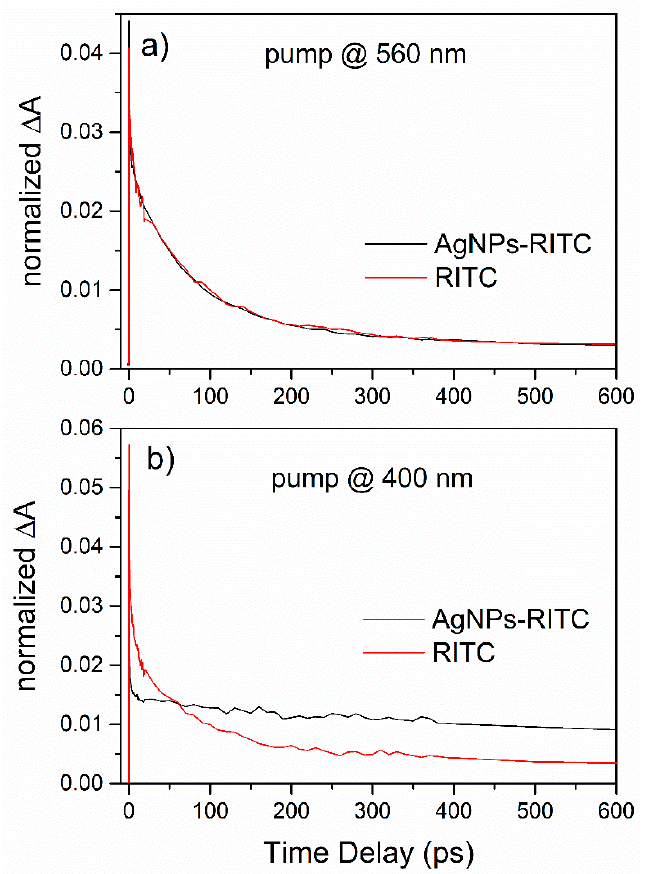
Figure 6. ( a ) Normalized dynamics of fluorescence of AgNPs–RITC (black) and RITC (red) probed by transient absorption following photoexcitation on the dye absorption band at 560 nm (the probe was at 590 nm to avoid the scattering of the pump). ( b ) The normalized dynamics of the same band (probed at 560 nm in this case) revealed by transient absorption following photoexcitation on the localized surface plasmon resonance (LSPR) band of the Ag nanoparticles at 400 nm.